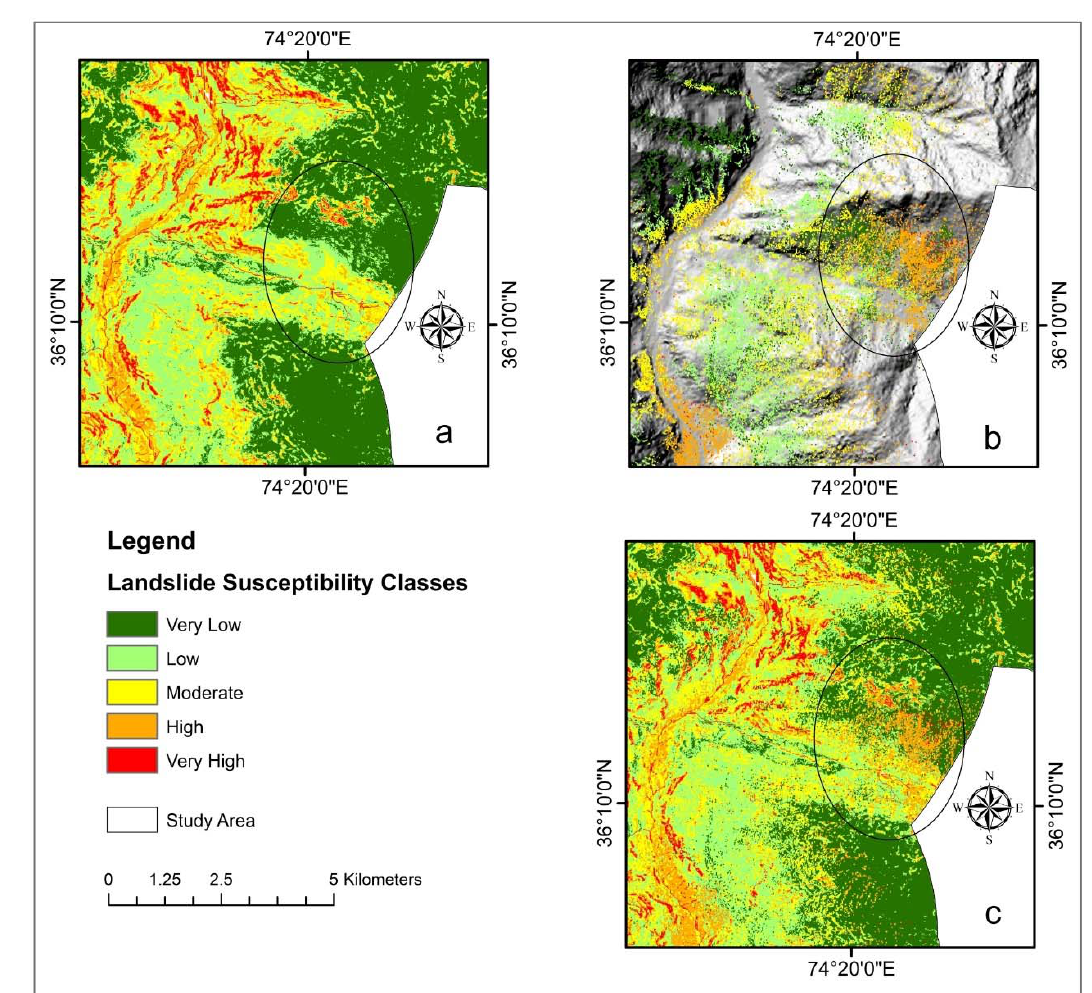
Figure 15. Results of landslide susceptibility near Chalt area. ( a ) LSM results were obtained using the XGBoost model. ( b ) PS-InSAR-based landslide deformation velocity (Vslope) map. ( c ) Improved landslide susceptibility map results.